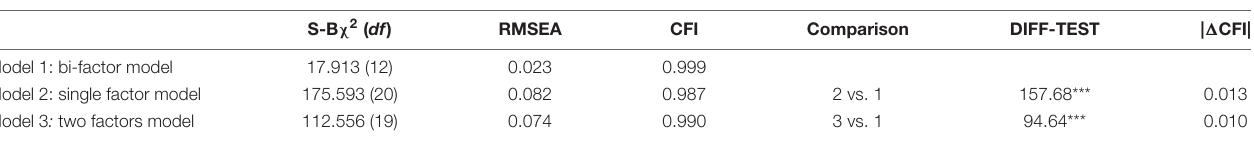
TABLE 3 | Study 2. Model